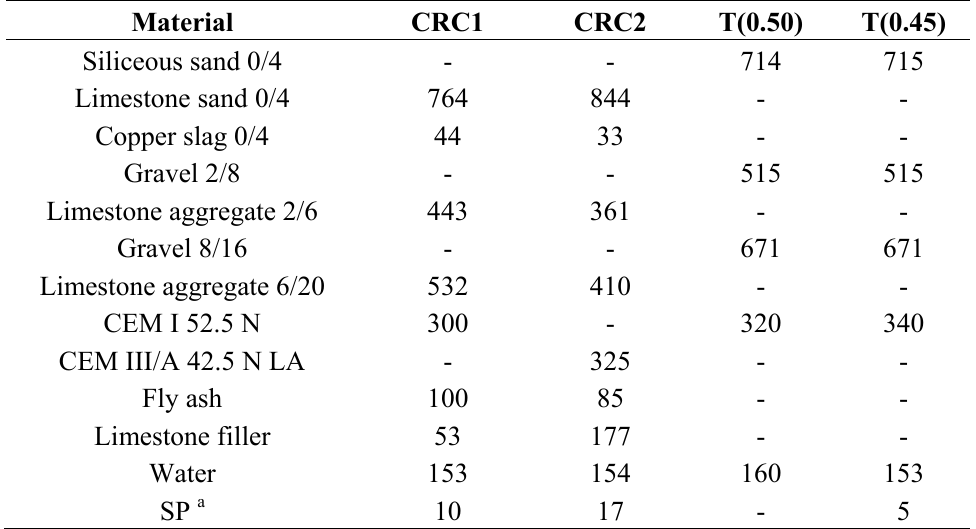
Table 1. Overview of the compositions of the studied concrete types (kg/m 3